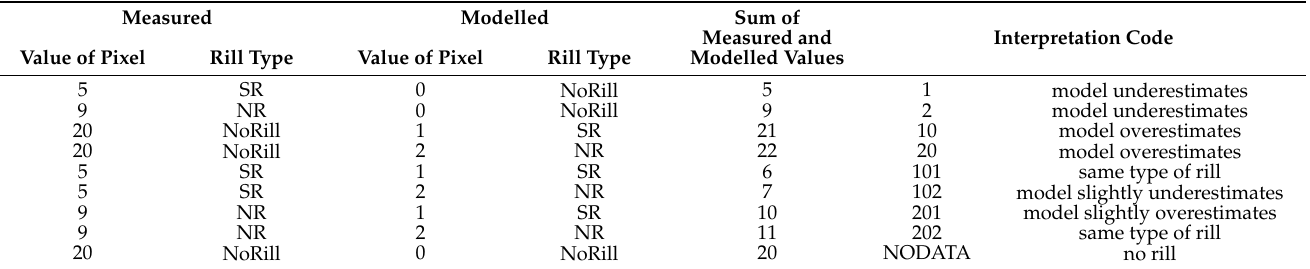
Table 1. Classification of measured and modelled pixels based on the status of the rills: significant rills SR, noticeable rills NR, and pixels without a rill